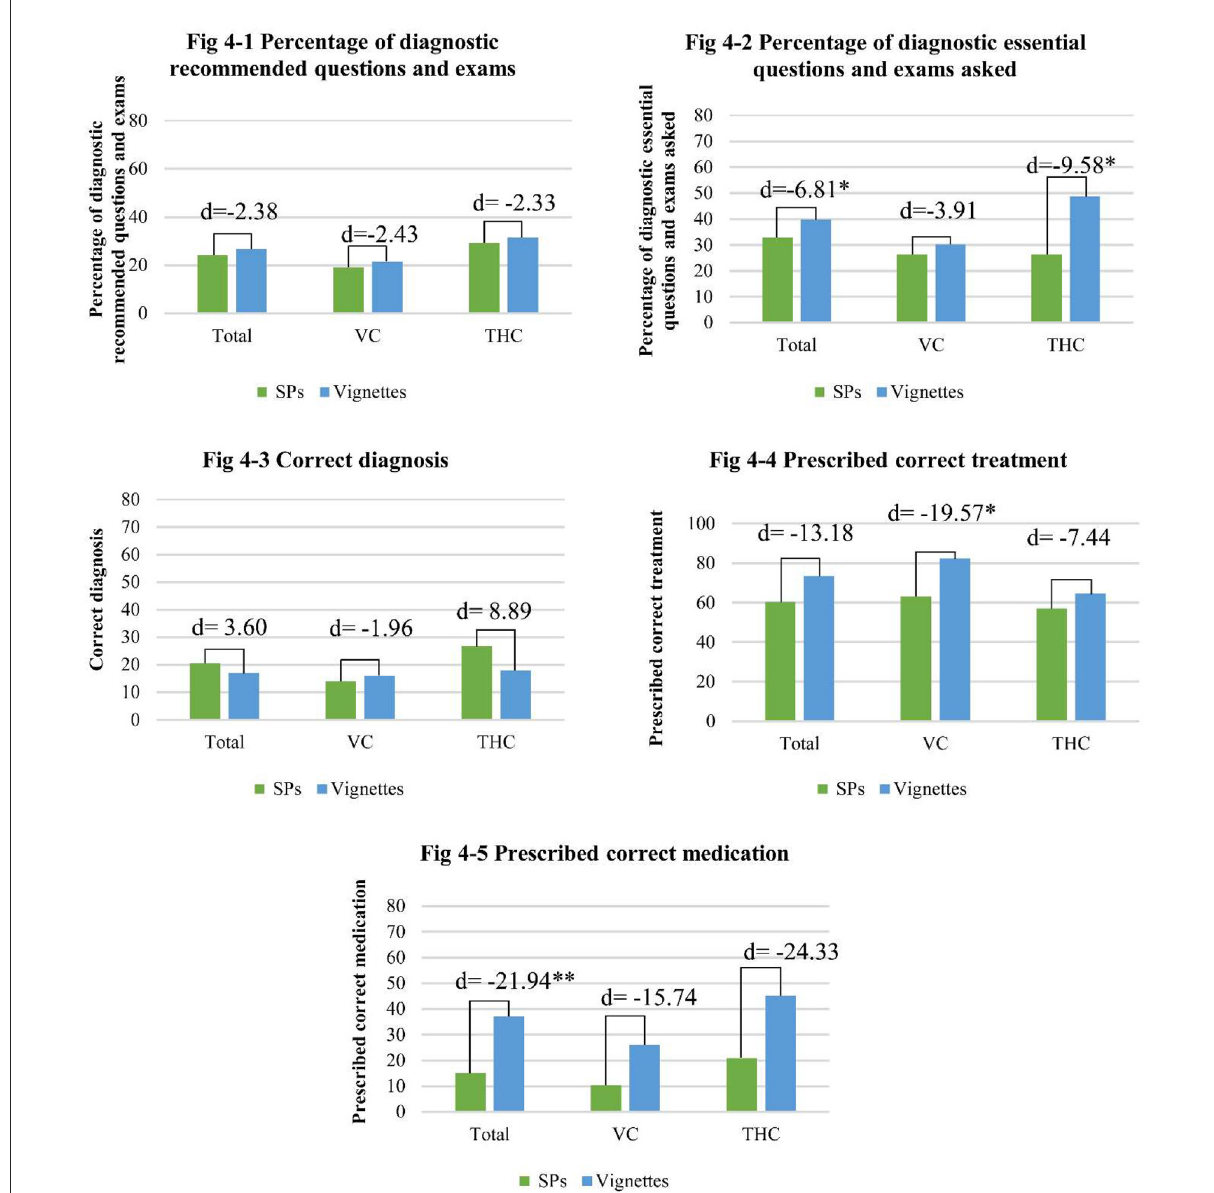
FIGURE4 The know-do gap of diagnostic questions asked and diagnosis and treatment given for angina cases (* p < 0.05, ** p < 0.01).